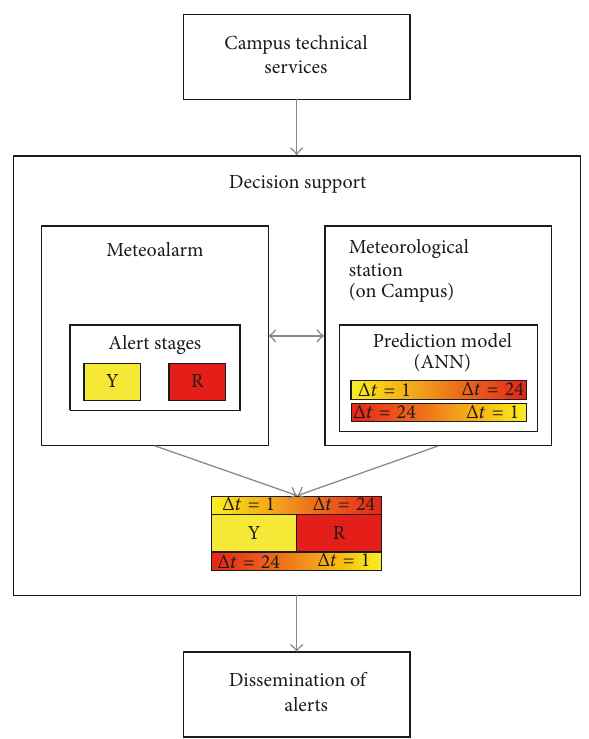
Figure 5: Scheme of the proposed